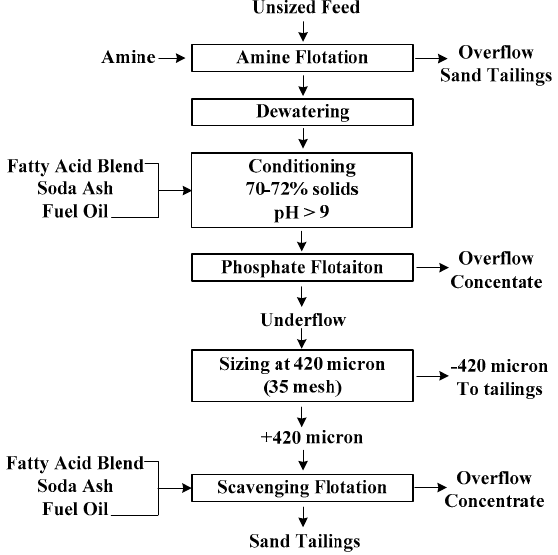
Figure 1. The reverse “Crago” double float process for beneficiation of Florida phosphate ore [6].